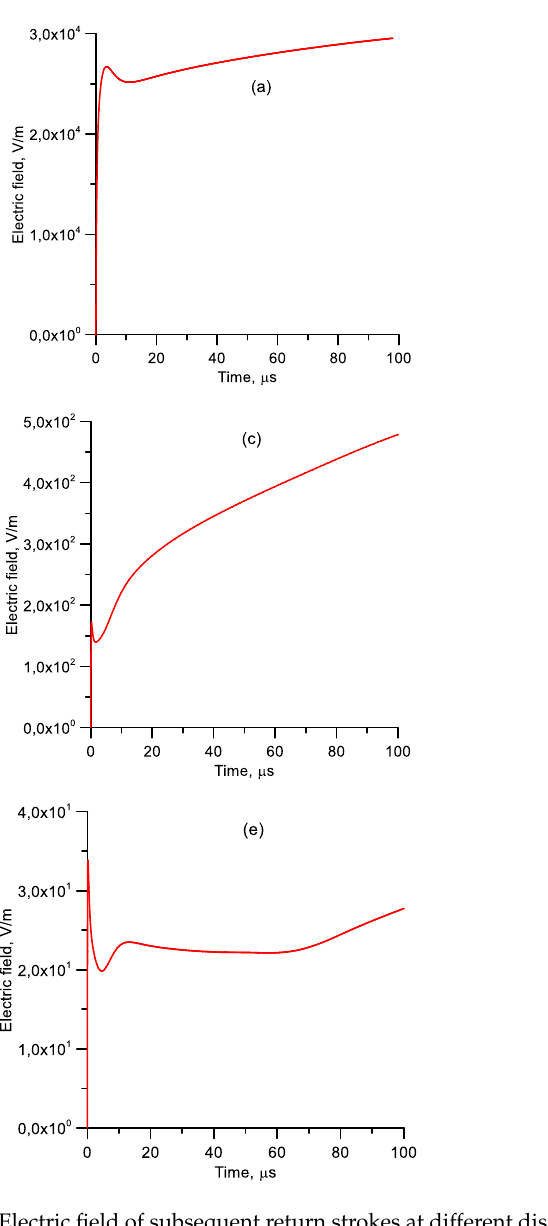
13 of 24 Figure 7. Radiation field at 100 km for different forms of the dispersion function. (1) 